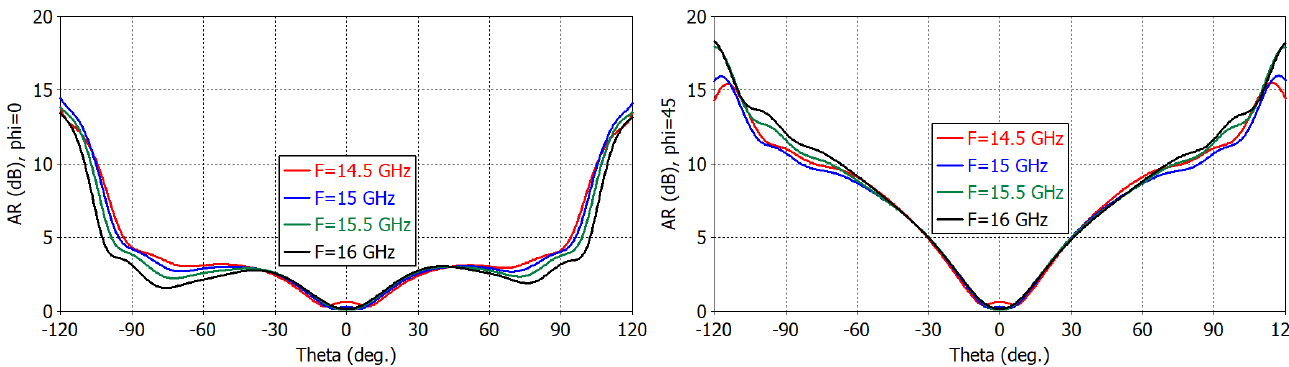
Figure 9. RHCP axial ratio patterns of the sum